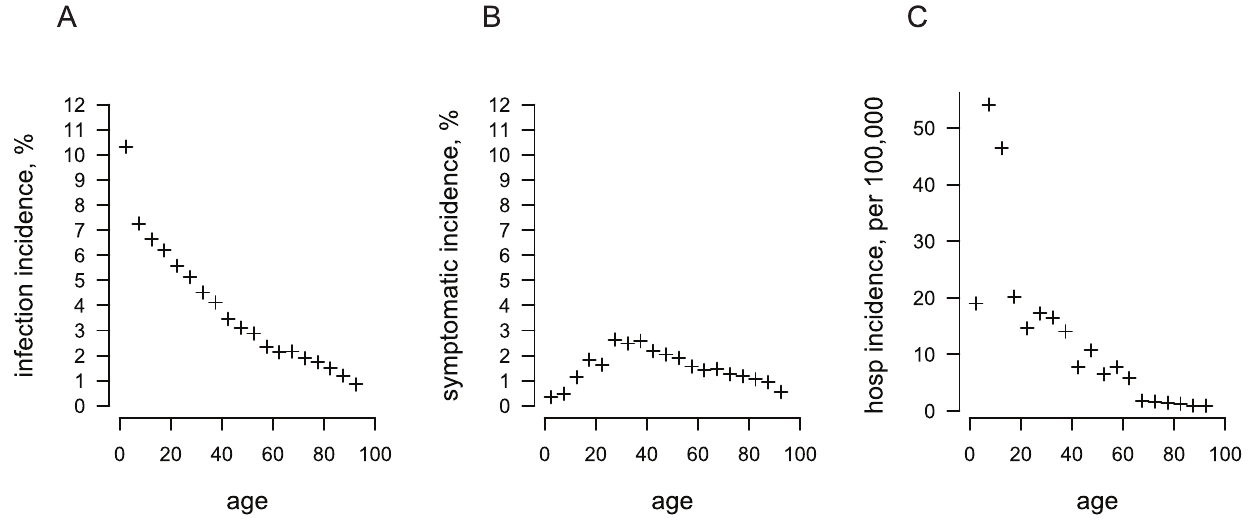
Figure 5. Simulated incidence of dengue infection and illness by age in a simulated season. Plotted are the average age-specific (A) infection incidence, (B) dengue fever incidence, and (C) hospitalized DSS/DHF incidence per year from fifty stochastic simulations and aggregated in 5-year age brackets.